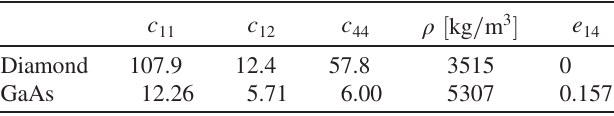
TABLE II. Material properties [26] for both diamond and GaAs. The elastic tensor c has three independent parameters, given in units of ½ 10 10 N = m 2 (cid:2) , while the piezoelectric tensor e has a single independent parameter e 14 for cubic materials (units of C = m 2